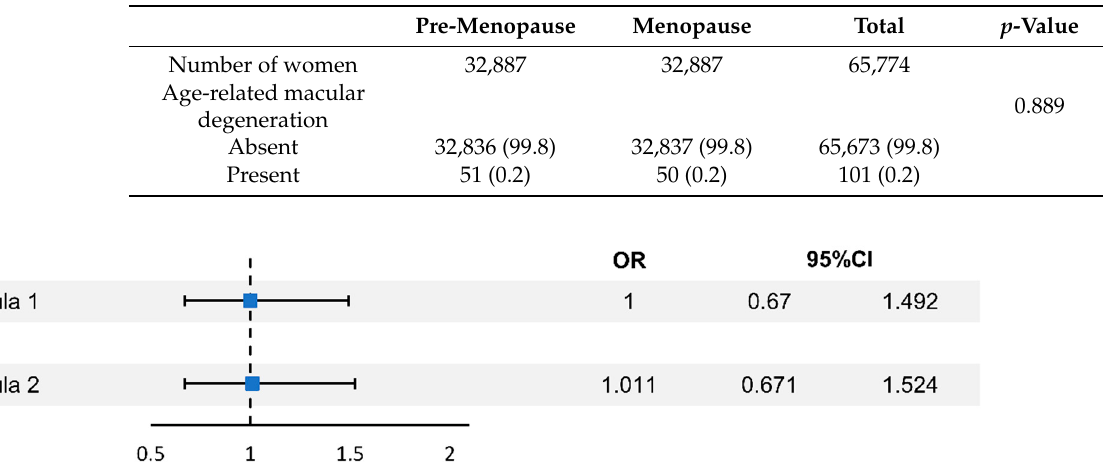
Figure 2. Odds ratios for risk of age-related macular degeneration according to menopause. Korea